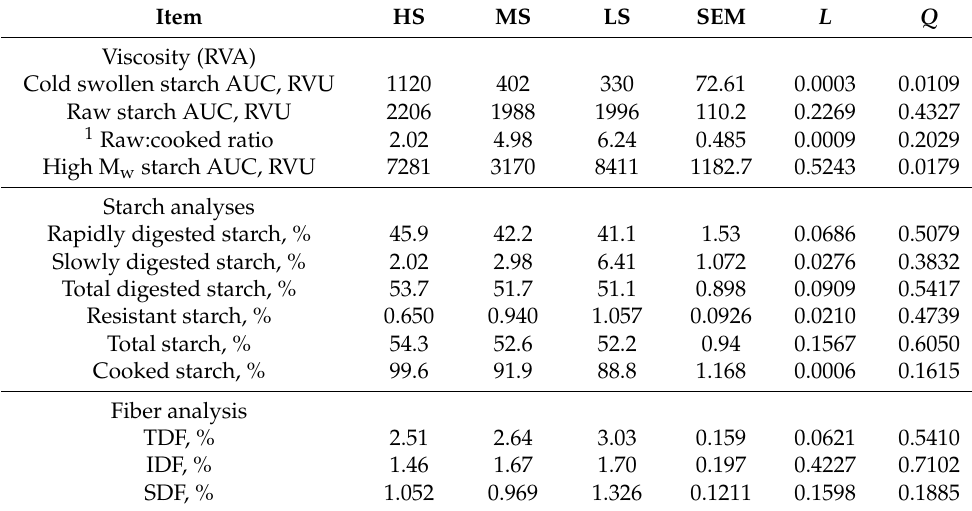
Table 5. Least square means and contrasts [high vs. medium and low shear (T); linear (L); quadratic (Q)] for starch analyses from diets containing three levels of cooking. Item HS MS LS SEM L